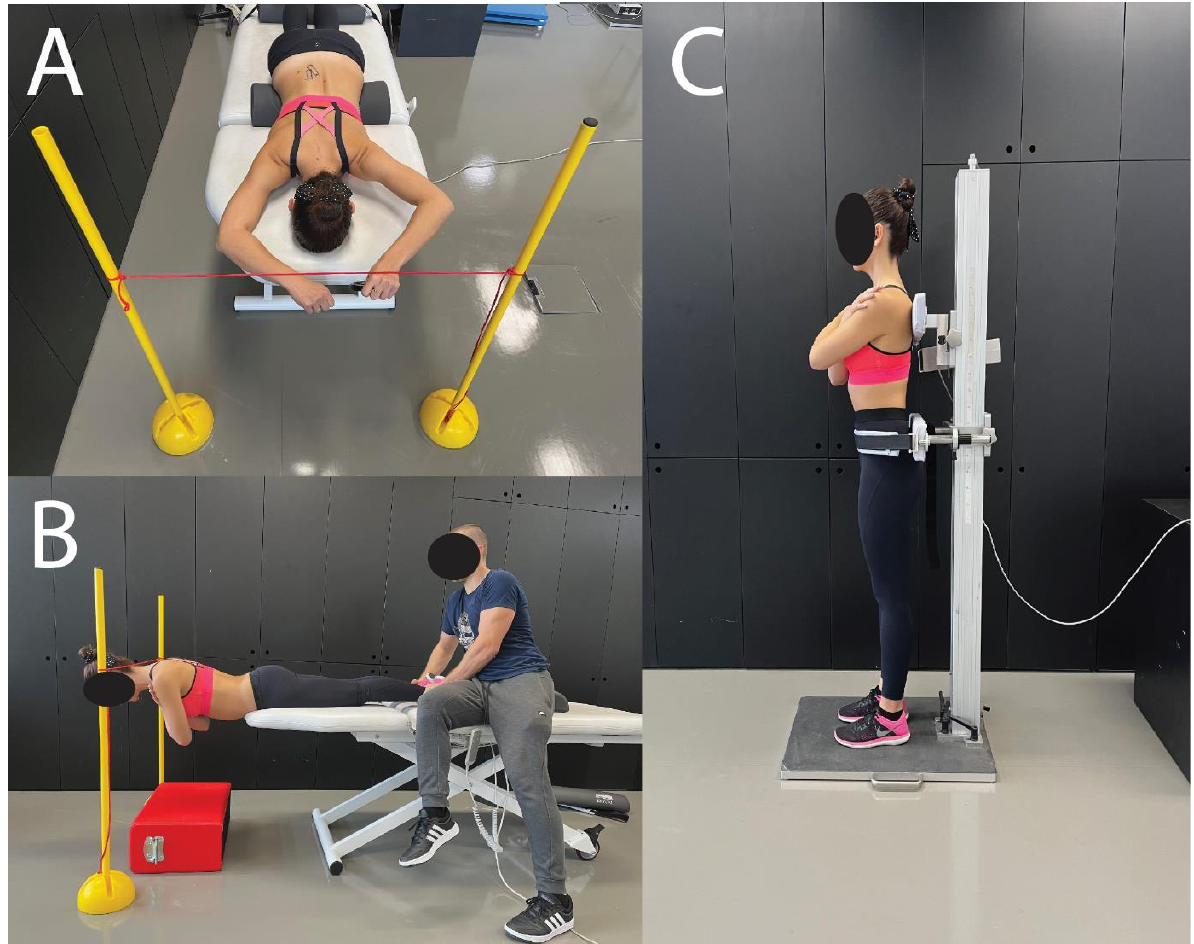
Figure 3. Participant positioning for low-level ( A ) and high-level contractions ( B ) and set-up for isometric trunk extension force measurements ( C ). Ultrasound measurements are not shown in figures A and B to allow clearer representation of the participant positions.